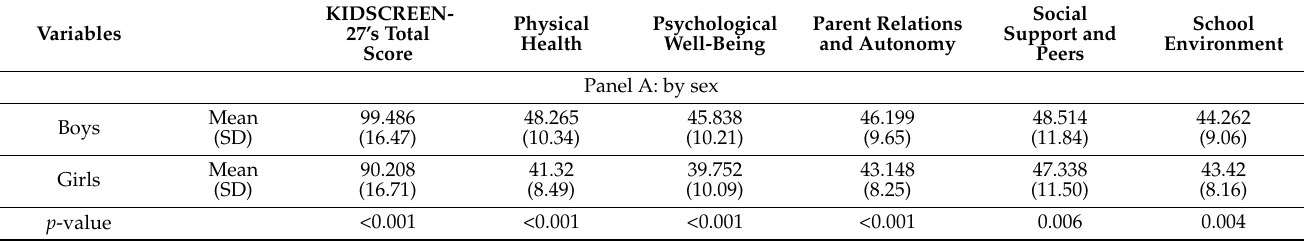
Table 2. Summary statistics for the KIDSCREEN-27’s total score and all the